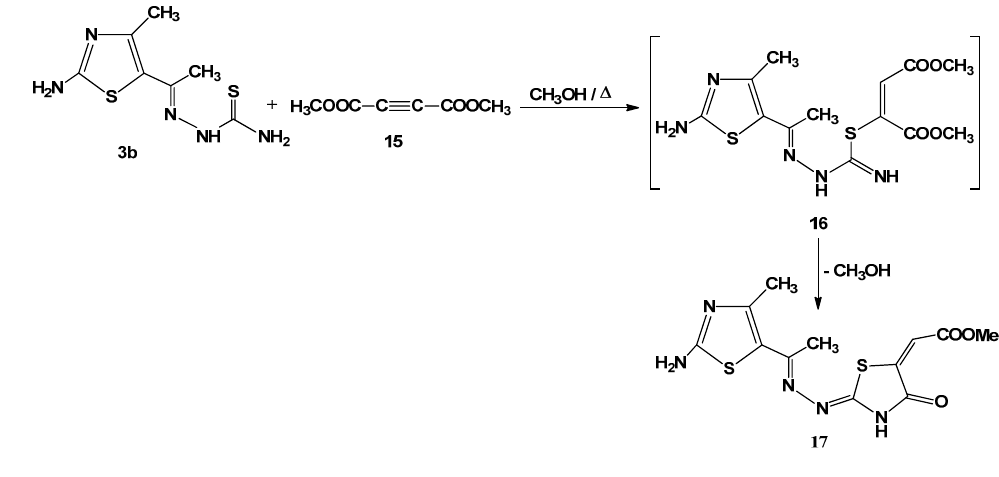
Figure 1. Viability chart of tested Group 1 compounds against HEP G2 cell line.